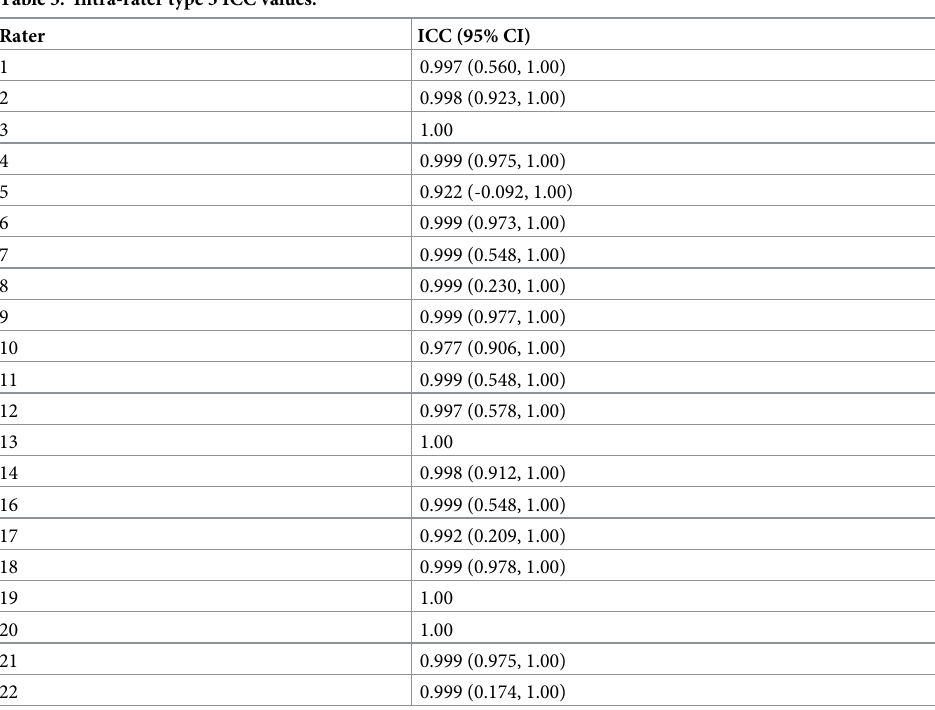
Table 3. Intra-rater type 3 ICC